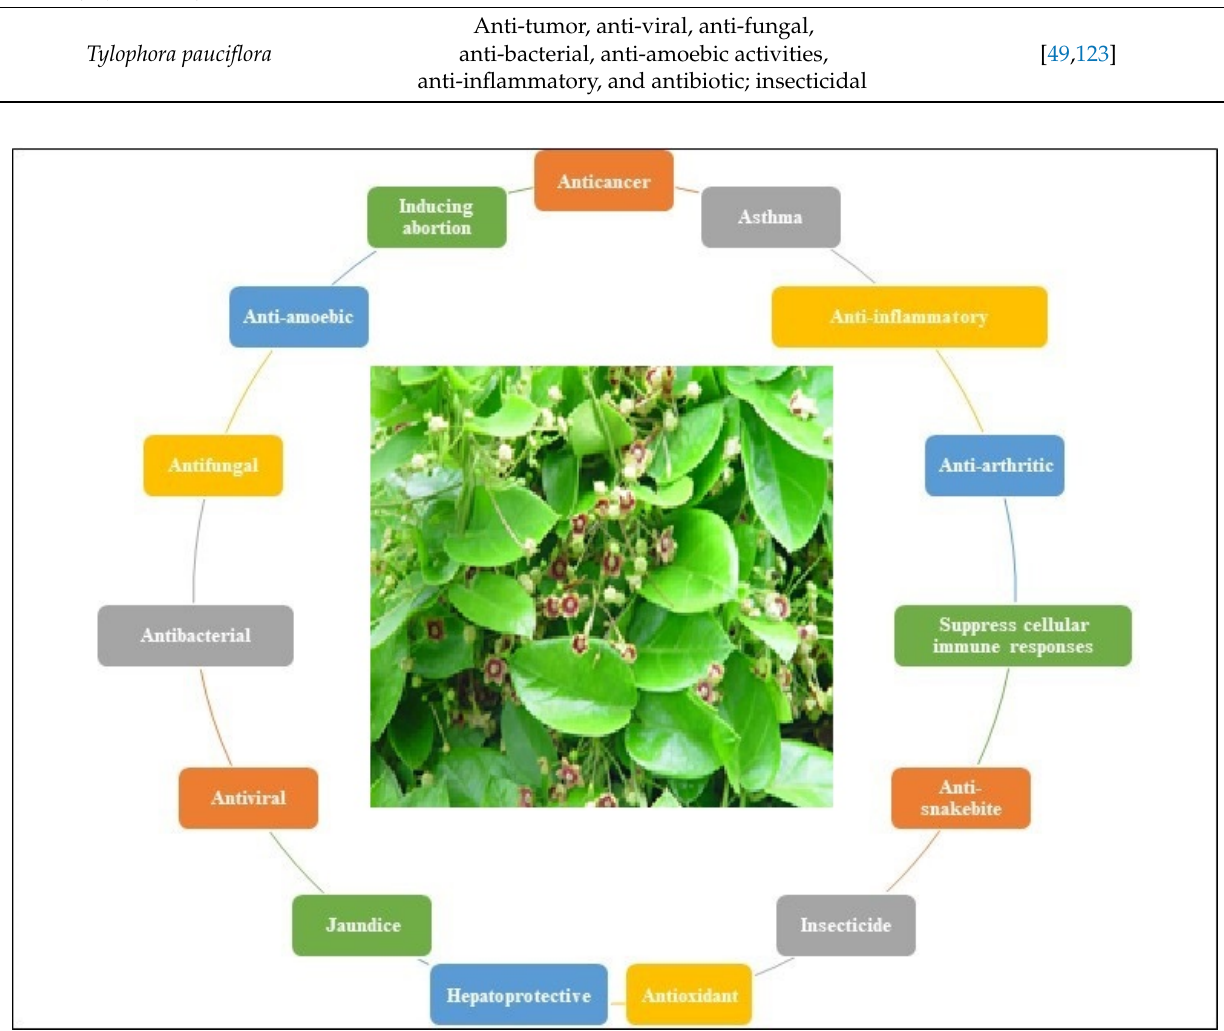
Figure 2. Important biological activities of the genus Tylophora (The plant picture is for T. indica ). Table 5. Uses and biological activities of various Tylophora species.